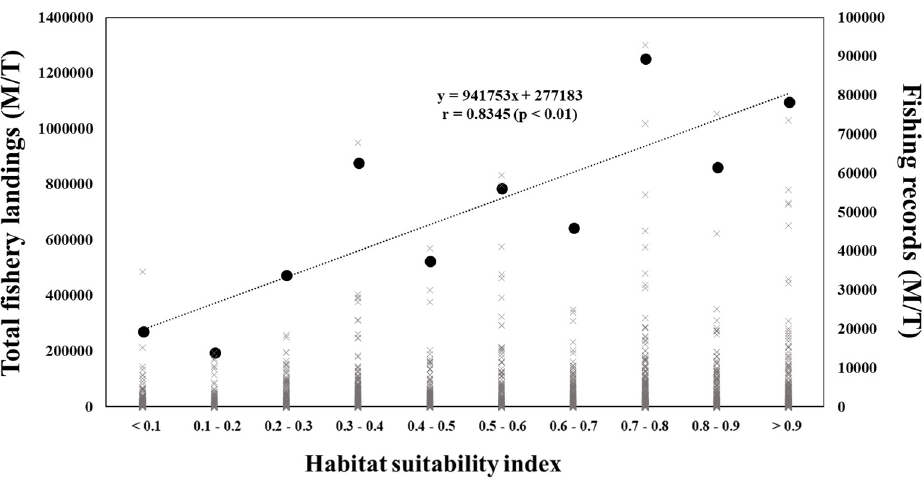
Figure 6. Climatological monthly distribution of the HSI around South Korea from 2002 to 2016.